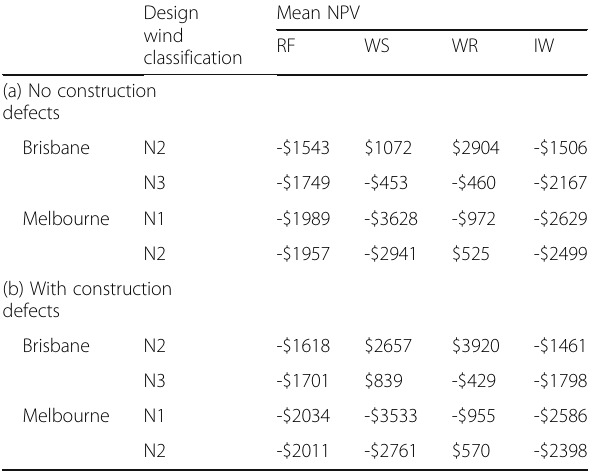
Table 9. It is indicated from Table 9 that an adaptation measure may turn to be cost-effective with reasonable dis- counts on the cost given by Table 6. For example, only a 13% discount on the adaptation cost makes WR cost- effective for the Brisbane house with a design wind classi- fication of N3, whereas a 50% reduction in cost is needed to enable IW to be cost-effective for the Brisbane house with a design wind classification of N2. A few adaptation measures can remain cost-effective even with significantly increased costs. For example, WR is still cost-effective for N2, if the anticipated cost of WR given by Table 6 in- creases by 300%.